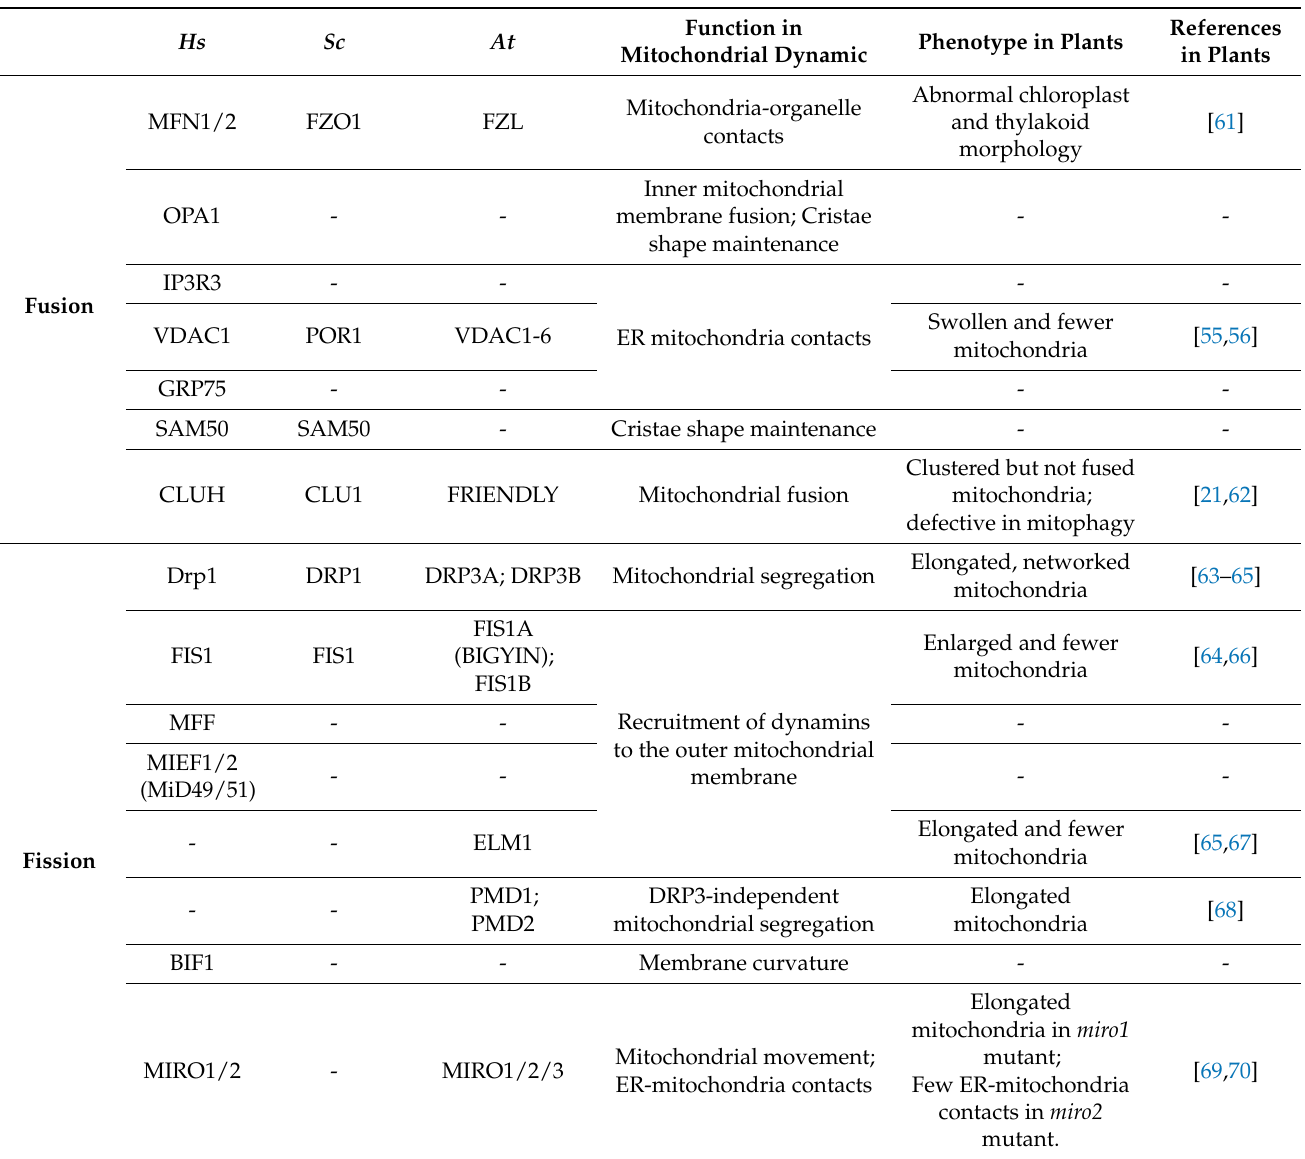
Table 1. Key mitochondrial fusion and fission factors